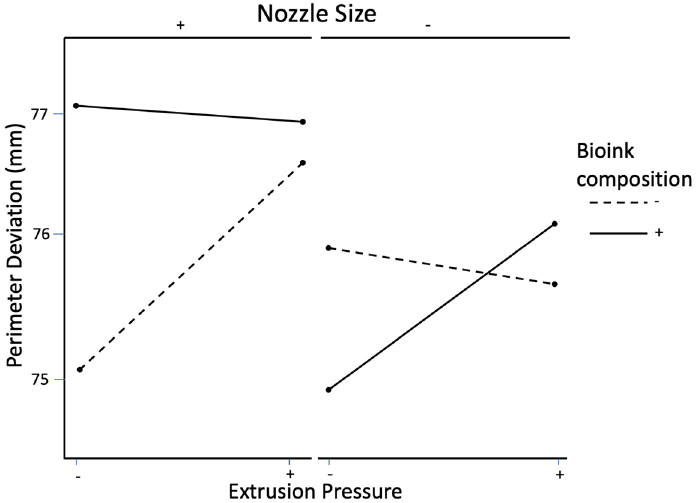
Figure 9. Interaction effect on perimeter deviation between nozzle size and bioink composition.